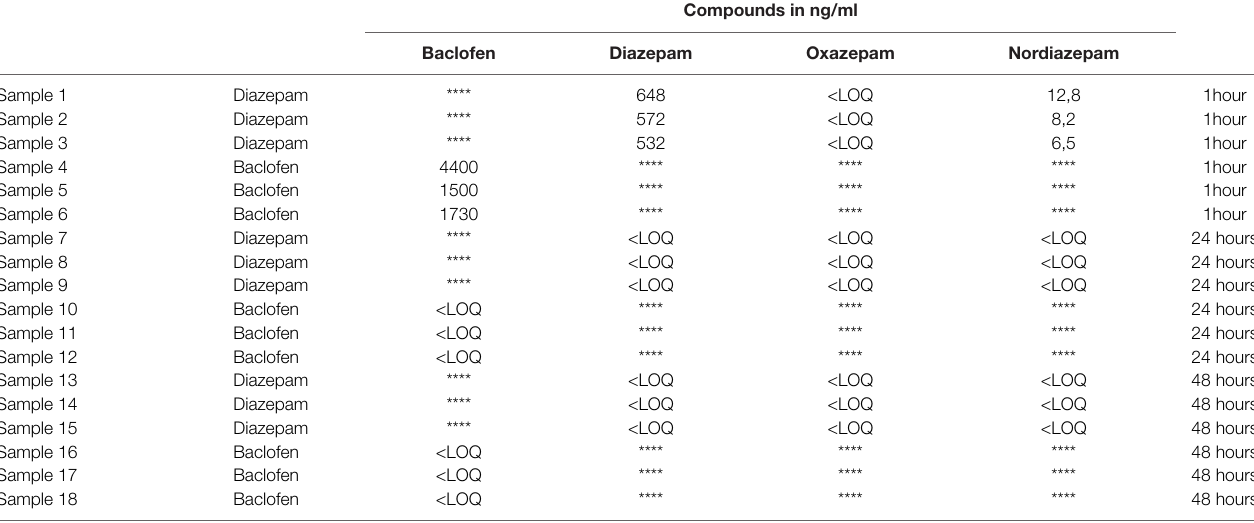
TABLE 1 | Mean concentrations (in ng/mL) of baclofen and diazepam, and their active metabolites oxazepam and nordiazepam ( N = 3 subjects per sampling time) by LC-MS-MS technique. Baclofen, diazepam, and nordiazepam were detected and quantified in the blood of animals 1 h after the last injection, but their concentrations were below the limit of quantification (<LOQ) for the 24- and 48-h points.